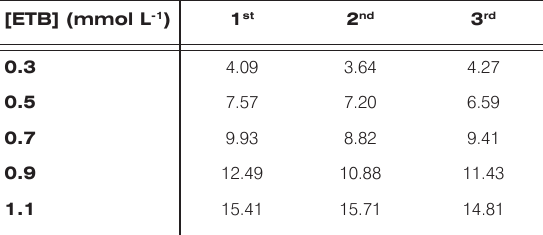
Table 5. Signal replicate values used for CZE regression model implementation.